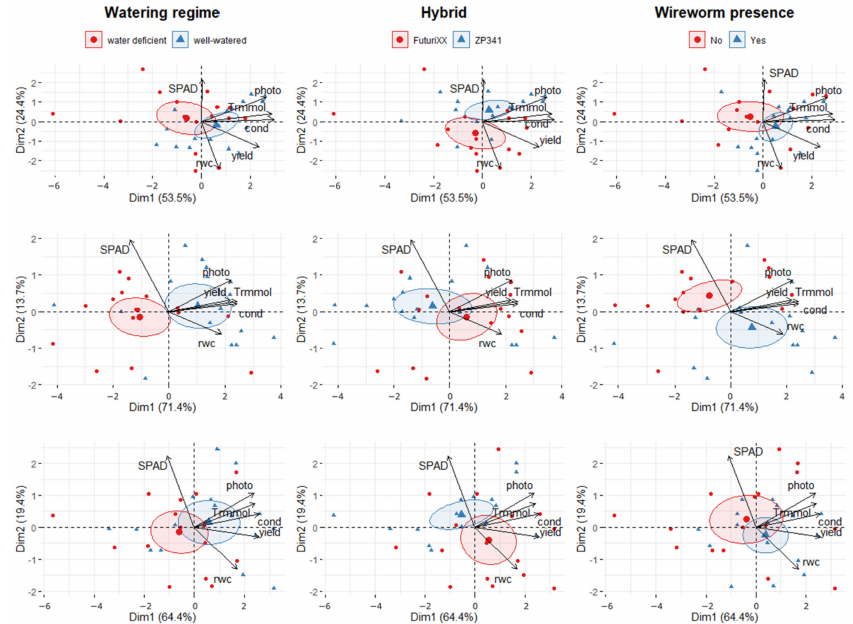
Figure 8. Physiological characterisation by principal component analysis (PCA) comparing maize plants of different hybrids (ZP341 vs. FuturiXX in the middle column), under different watering regimes (well-watered vs. water-deficient in the left column) and subjected to herbivory (no wire- worms vs. wireworm-infested in the right column). The first axis (Dim1) explains 53.5% of the accumulated variance, and the second axis (Dim2) explains 24.4% of accumulated variance on day 14 (first row); the first axis (Dim1) explains 71.4% of the accumulated variance, and the second axis (Dim2) ex-plains 13.7% of the accumulated variance on day 21 (second row); and lastly, the first axis (Dim1) explains 64.4% of the accumulated variance, and the second axis (Dim2) explains 19.4% of the accumulated variance on day 28 (third row). rwc: relative water content; yield: effective quantum yield of PSII; cond: stomatal conductivity; Trmmol: transpiration rate; photo: net photosynthesis; SPAD: chlorophyll